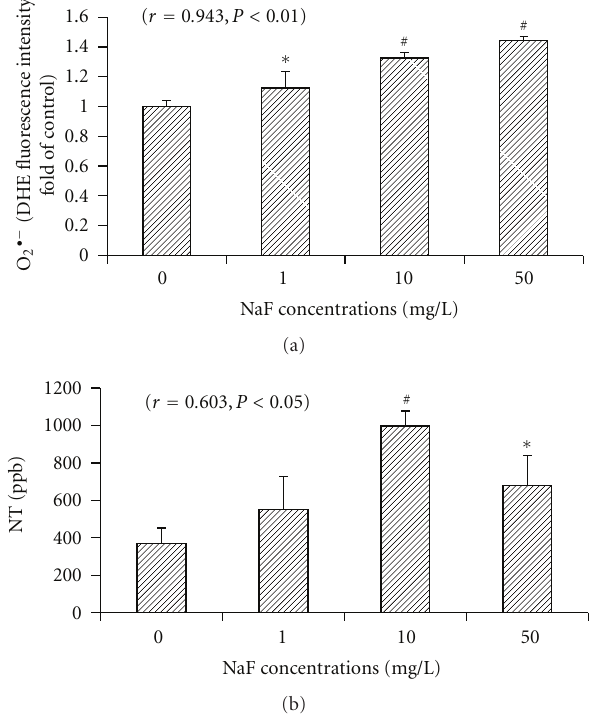
Figure 5: E ff ects of fluoride on O 2 •− production (a) and NT concentrations (b) in microglial BV-2 cells. BV-2cells were treated with various concentrations of NaF (1, 10, and 50 mg/L) for a 24h incubation period, and DHE fluorescence intensity was measured by flow cytometry for O 2 •− content and DHE fluorescence intensity fold of control was analyzed. Intracellular NT concentrations were measured by ELISA. Bars were presented as mean ± SD. ∗ P < 0 . 05 and # P < 0 . 01 compared to the control